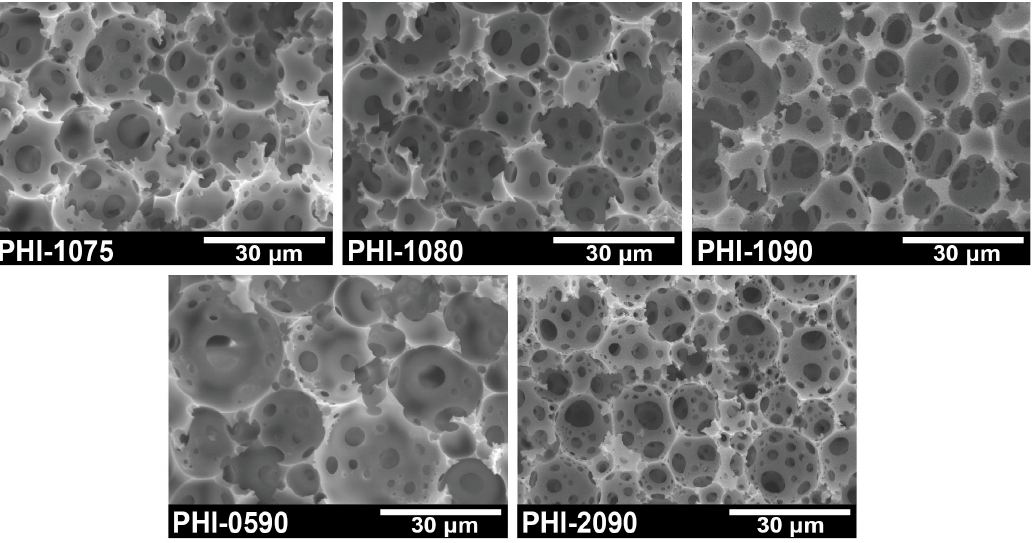
Figure 1. SEM images of open-cell polyHIPE scaffolds. Table 1. Composition of emulsion templates and properties of the resulting polyHIPEs.